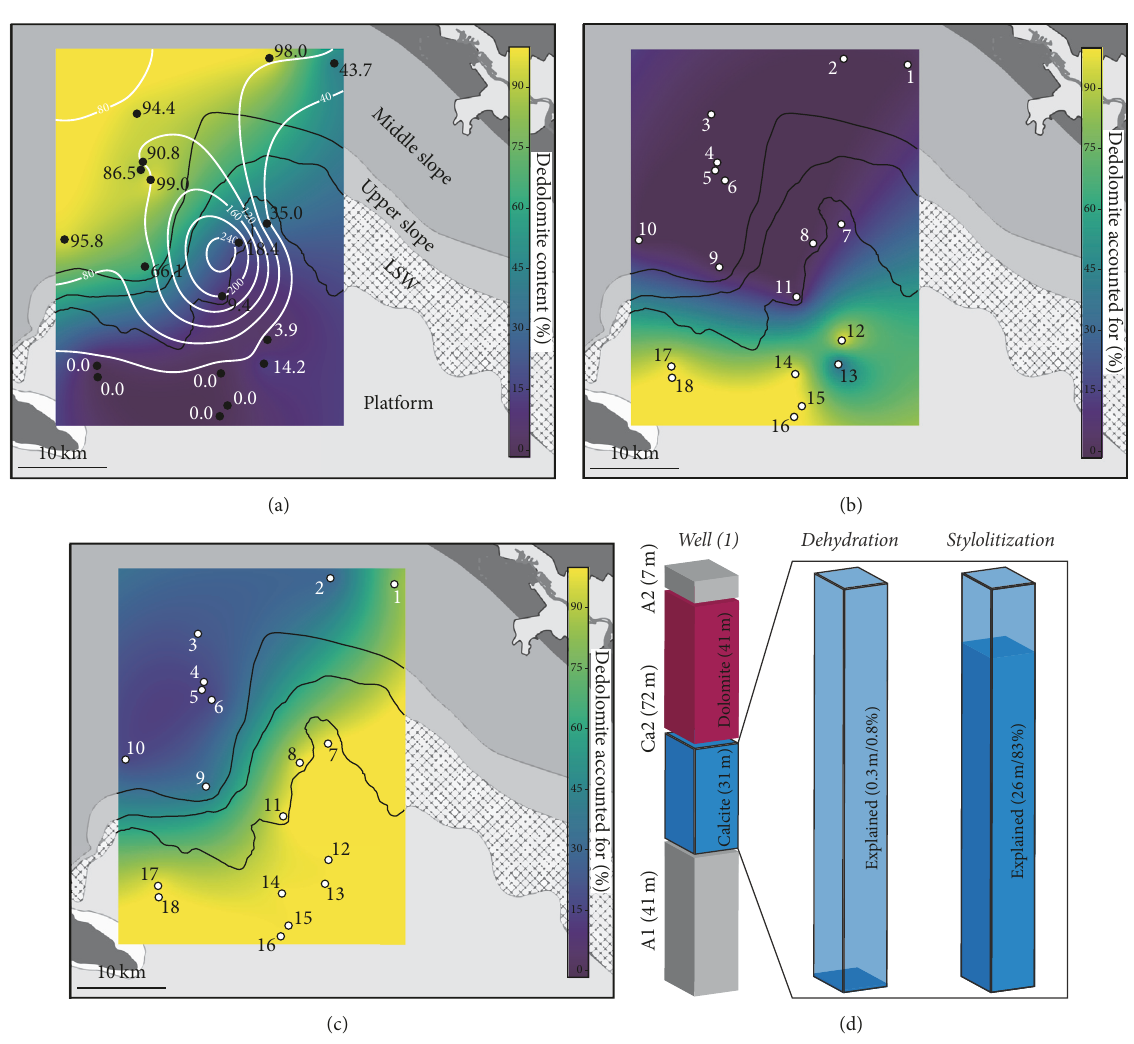
Figure 7: (a) The contour map displays the color coded percentage (0–100%) of dedolomite on the Ca2 bulk sediment within the study area. Values are interpolated from the well data provided by EMPG and annotated at each well. White contour lines represent the distribution of thickness of the Ca2 within the study area. (b + c) The contour maps represent the discrepancy between the dedolomitization potential of the calculated dehydration fluids (b) and fluids released due to pressure solution (c) and the actual observed amount of dedolomite. All contour maps overlie the paleogeography of the Ca2 in northern Germany during late Permian times (modified after Strohmenger et al. [1]). (d) Dedolomite content and dedolomitization potential of dehydration and pressure solution fluids were determined on a well-by-well basis (here Well (1) ) and then interpolated between the wells to create the contour maps in (b) and (c).